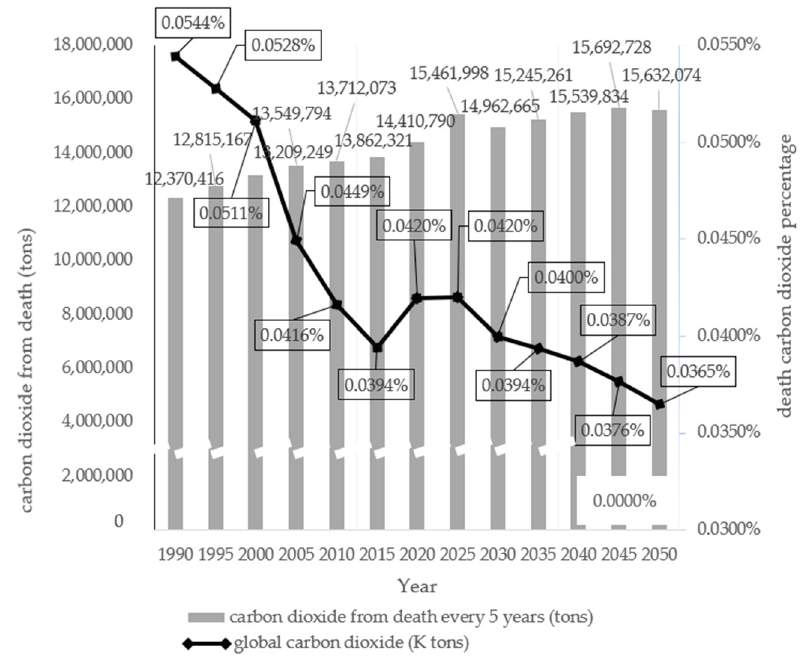
Figure 3. The simulation of carbon dioxide generated from the death toll from 10% to 30% every 5 years between 2030 and